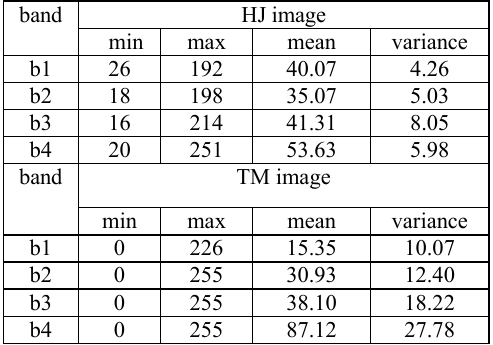
Tab.1 Statistics values of HJ image and TM image